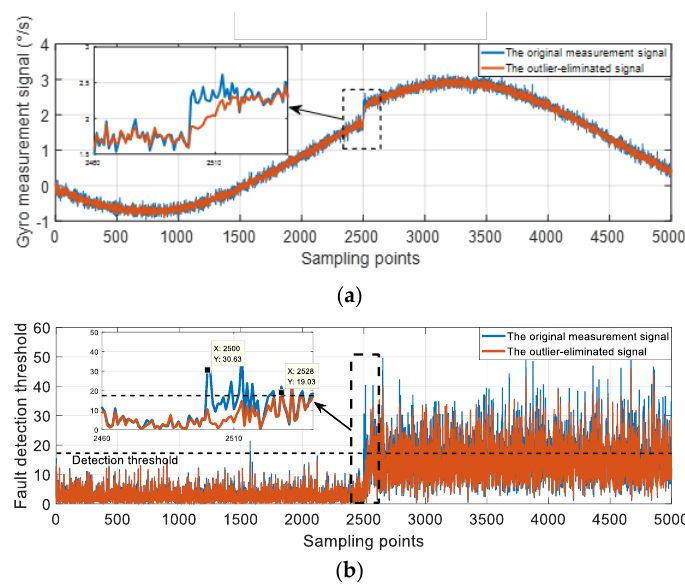
Figure 5. The influence of outlier eliminating. ( a ) The measurement signals; ( b ) the detection function.